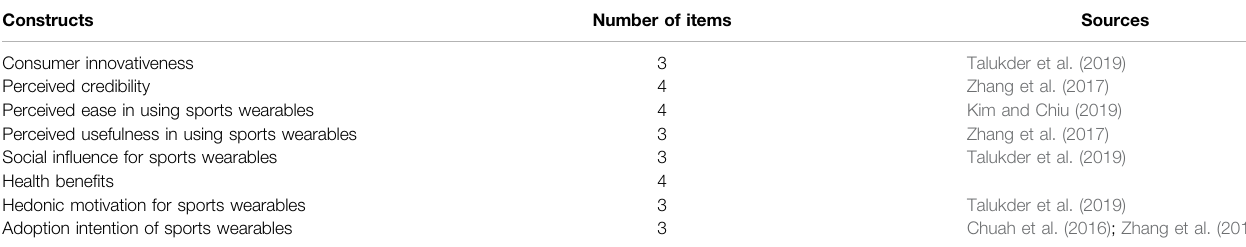
TABLE 1 | Source of